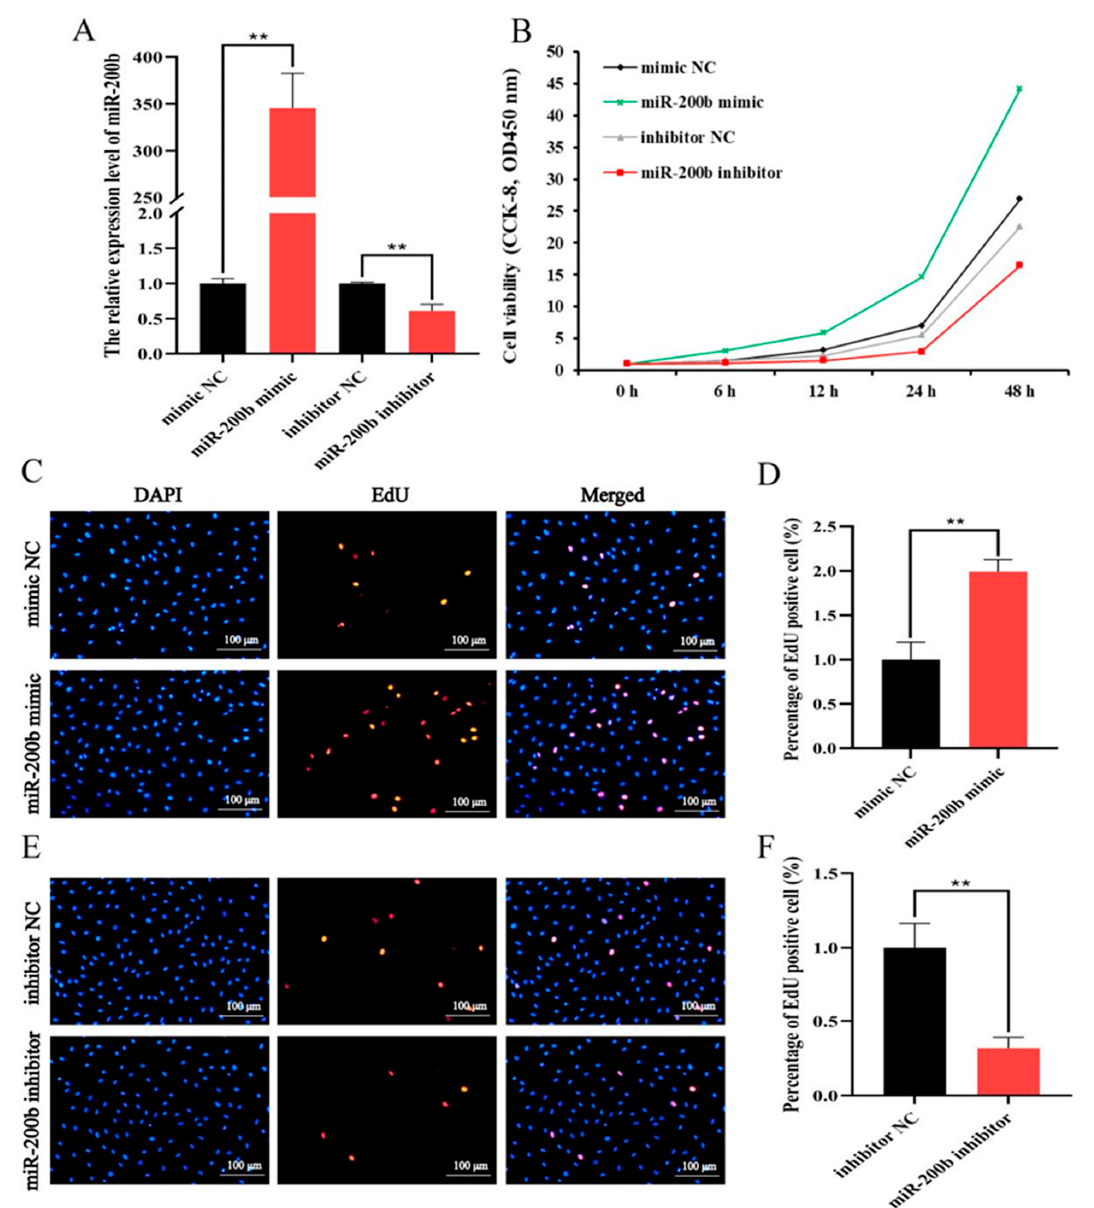
Figure 2. The effects of miR ‐ 200b on the proliferation of ovine preadipocytes transfected with miR ‐ 200b mimic, miR ‐ 200b inhibitor and negative control (NC). ( A ) The transfection efficiency of miR ‐ 200b in ovine preadipocytes on day 2 after transfection. ( B ) The proliferation activity of ovine preadipocytes was analyzed using CCK ‐ 8. ( C , E ) The EdU analysis of ovine preadipocytes. The images of DAPI and EdU reflect the total number of preadipocytes and the number of EdU ‐ labeled preadipocytes, respectively. The image of Merged reflects the proportion of EdU ‐ labeled preadipocytes in the total preadipocytes. ( D , F ) The proportion of EdU ‐ labeled preadipocytes in the total preadipocytes. The values represent mean ± SD ( n = 3), ** p < 0.01.